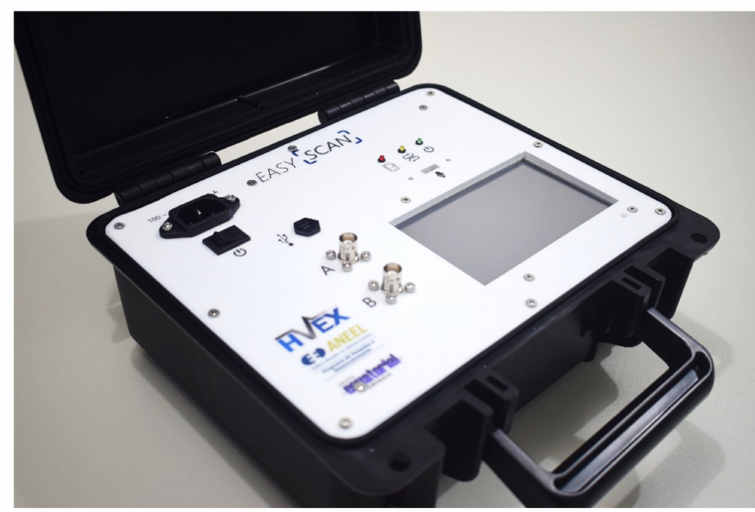
Figure 10. The portable instrument assembled in the protective